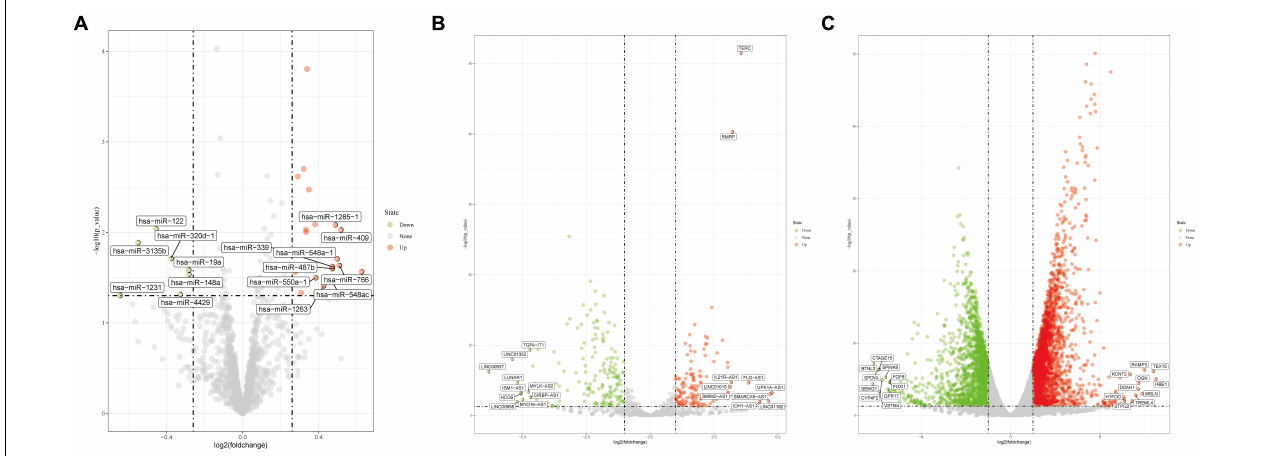
FIGURE 1 | Volcano plots for (A) differentially expressed miRNAs, (B) differentially expressed lncRNAs, and (C) differentially expressed